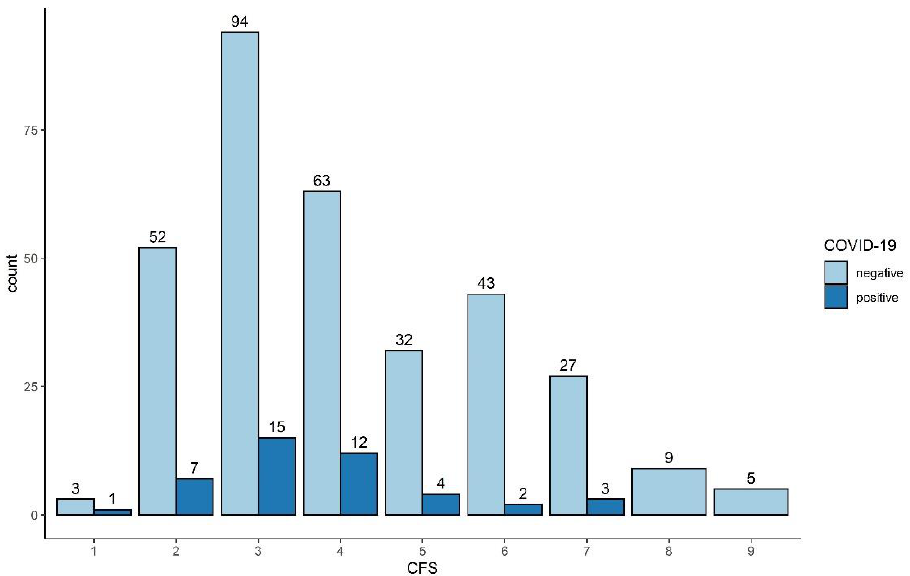
Figure A1. Distribution of CFS-levels in COVID-19 and non-COVID-19